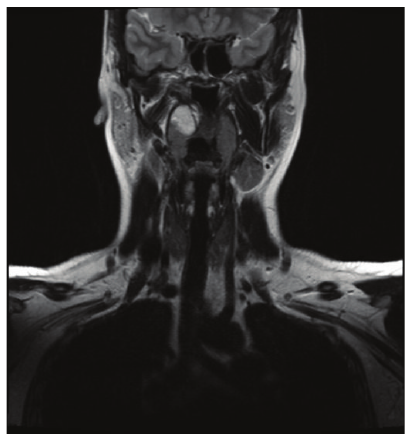
Figure 1: MRI shows a mass in the patient’s soft palate.